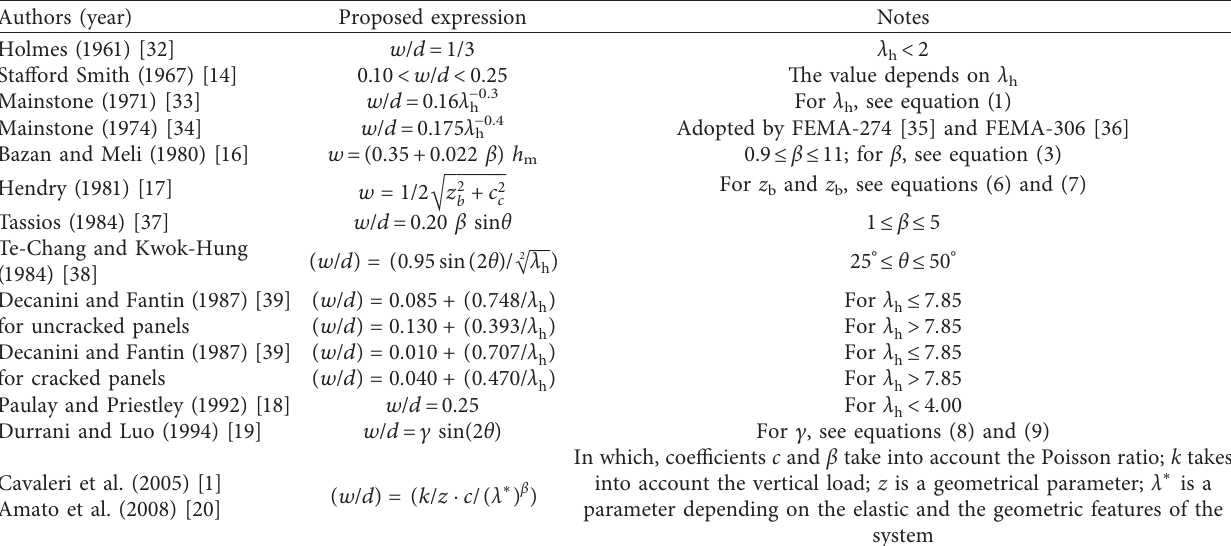
Table 3: Expressions proposed in literature for the evaluation of the w / d ratio (see